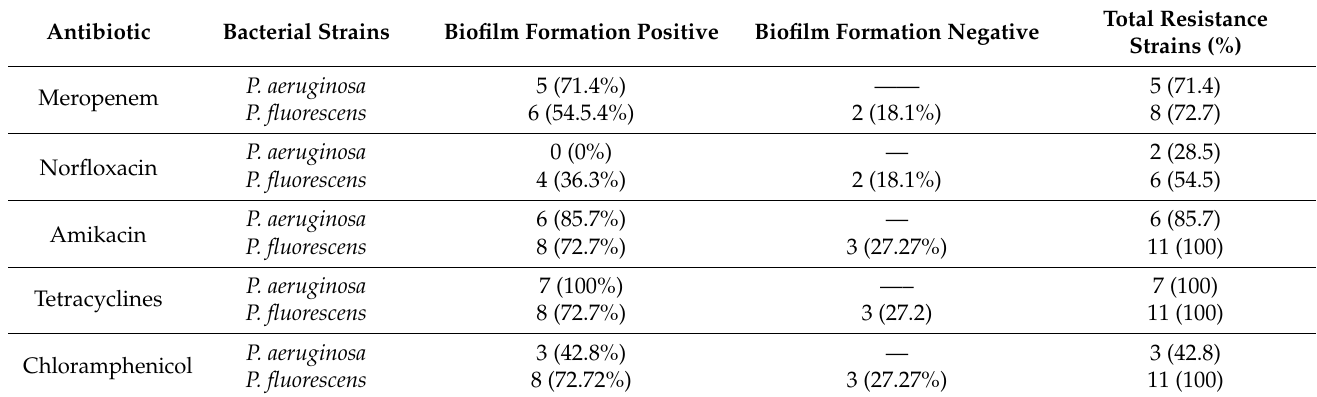
Figure 5. Gas chromatography–mass spectrometry (GC-MS) analysis of clove oil.